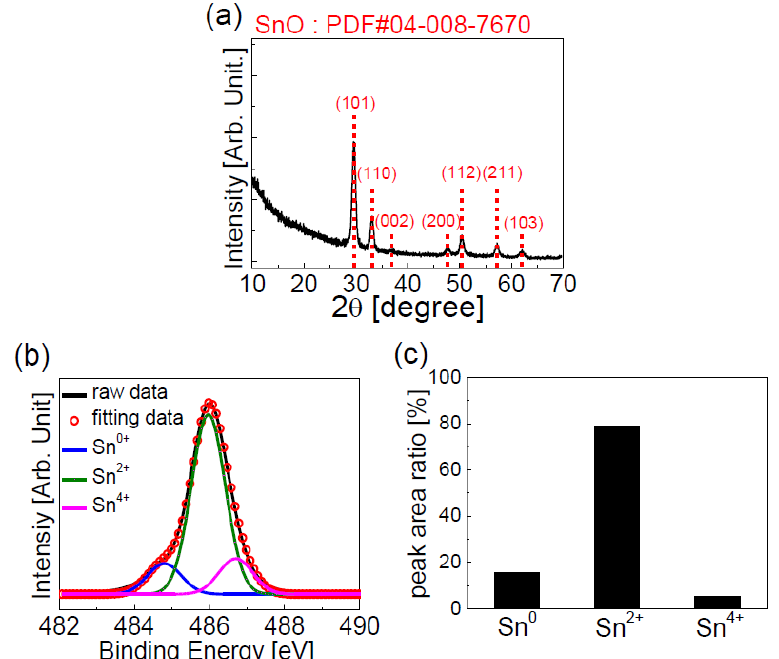
Figure 2. ( a ) XRD pattern; and ( b ) XPS Sn 3d 5/2 3 spectra of tin oxide thin film. ( c ) Relative peak area ratio of Sn 0 , Sn 2+ , and Sn 4+ components calculated from XPS spectra of tin oxide thin film.